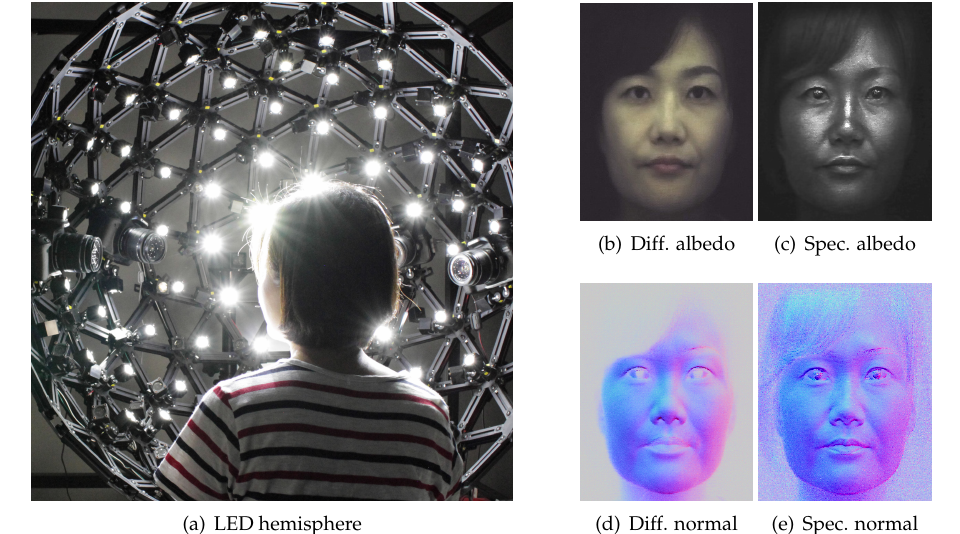
Figure 4. Our hemispherical illumination system and albedos and normals for separated diffuse and specular reflectance. ( a ) LED hemisphere for illuminating a subject with polarized spherical illumination. Separated diffuse ( b , d ) and specular ( c , e ) albedo and photometric normals of a female subject acquired using four measurements under polarized spherical gradient illumination (( c ) Eurographics Association 2016